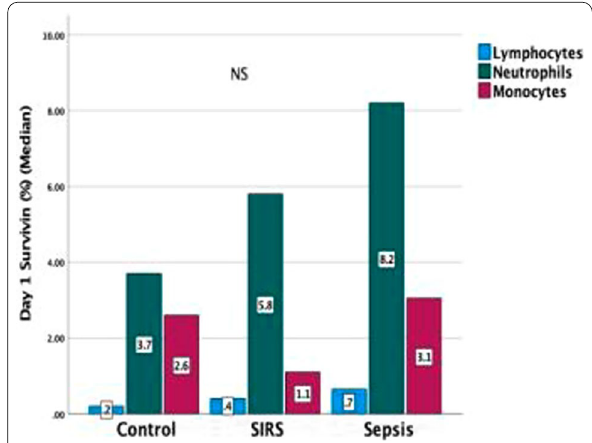
Fig. 1 Upregulated survivin expression in lymphocytes (p neutrophils (p 0,672) and monocytes (p = patients compared to non-infectious critically-ill patients and to healthy